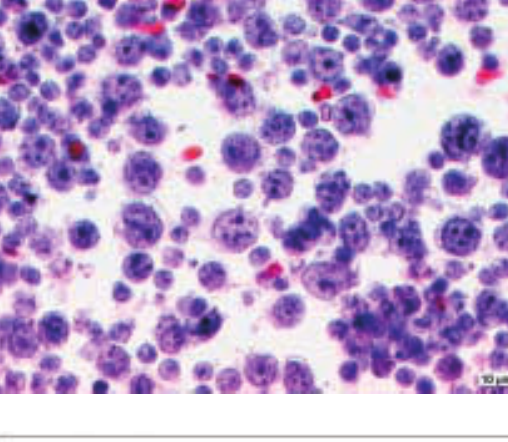
DNA histogram of pericardial effusion in patient (1) reveal- ing significant DNA- aneuploidy. Abcissa: DNA values in c-units; ordinate: number of measured nuclei. DNA mean value 4.64 (normal 2.0), DNA index 2.32 (normal 1.0), 2c devi- ation index 9.22 (nor- mal 0), 5c exceeding events 99 (normal 0), 9c exceeding events 0 (normal 0). Aneu- ploid DNA stemline